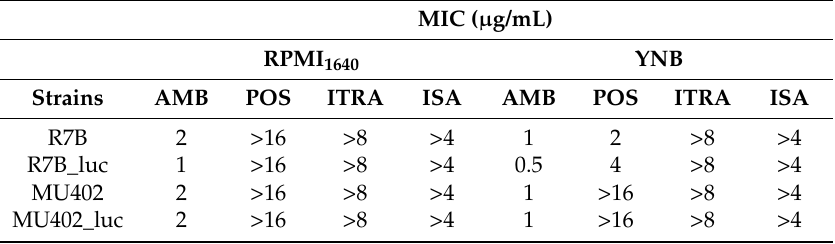
Table 3. Minimal inhibitory concentrations (MICs; µg/mL) determined for amphotericin B (AMB) and azoles (posaconozale: POS; itraconazole: ITRA; isavuconazole: ISA) according to European Committee on Antimicrobial Susceptibility Testing (EUCAST) guidelines. MICs were determined after 24 h of incubation at 37 °C, except for MU402 and MU402_luc, where MICs were read after 48 h of growth in yeast nitrogen base (YNB).